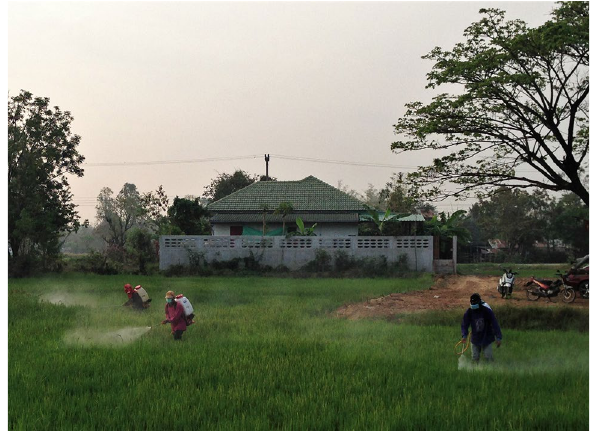
Figure 4. A cultivation area that is in close proximity to the residential